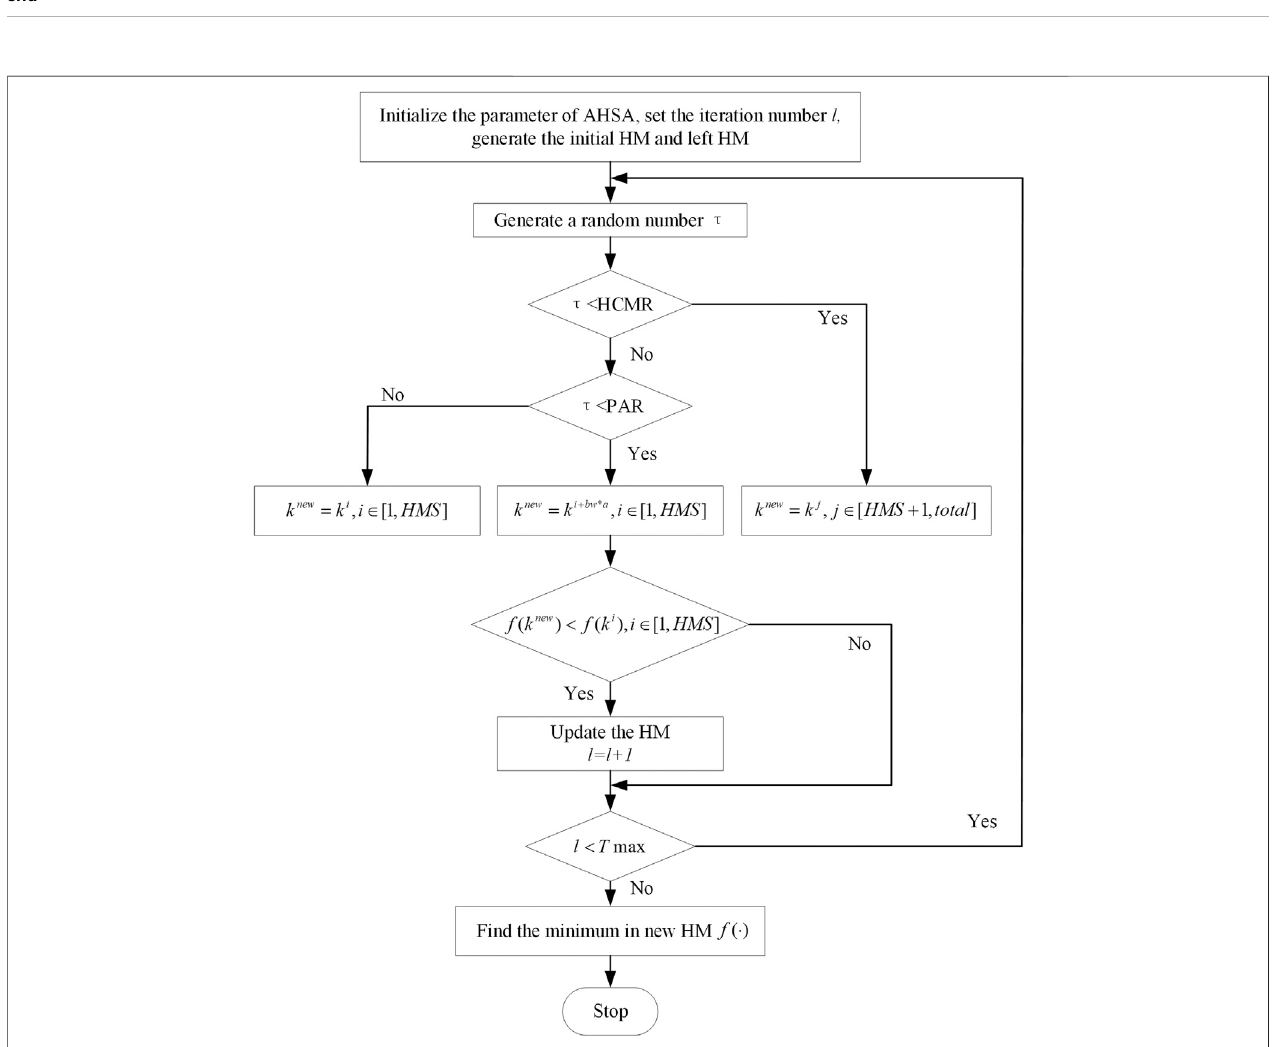
FIGURE 5 | Flowchart of